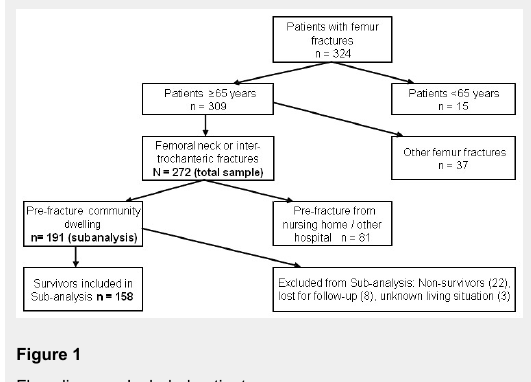
Flow diagram: Included